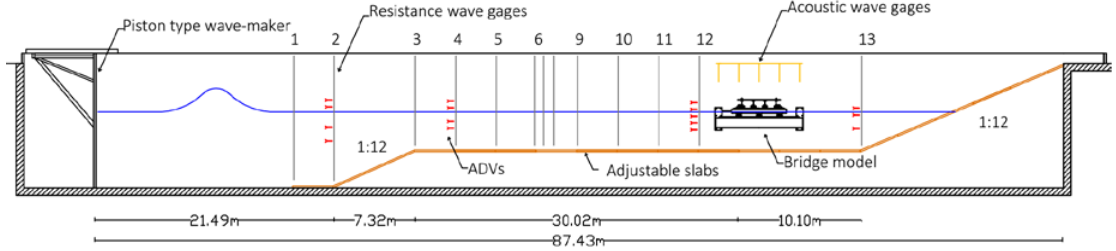
Figure 2. Cross-section of the Large Wave Flume (LWF) depicting the bathymetry, bridge location and flume instrumentation (not to scale). flume instrumentation (not to